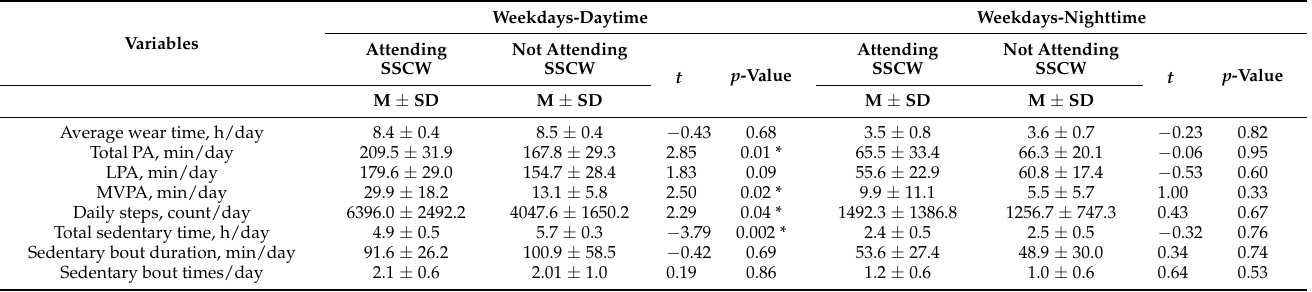
Table 3. Total amounts and patterns of physical activity and sedentary behavior in Prader-Willi syndrome adults with and without attending SSCW during the daytime and nighttime on weekdays.